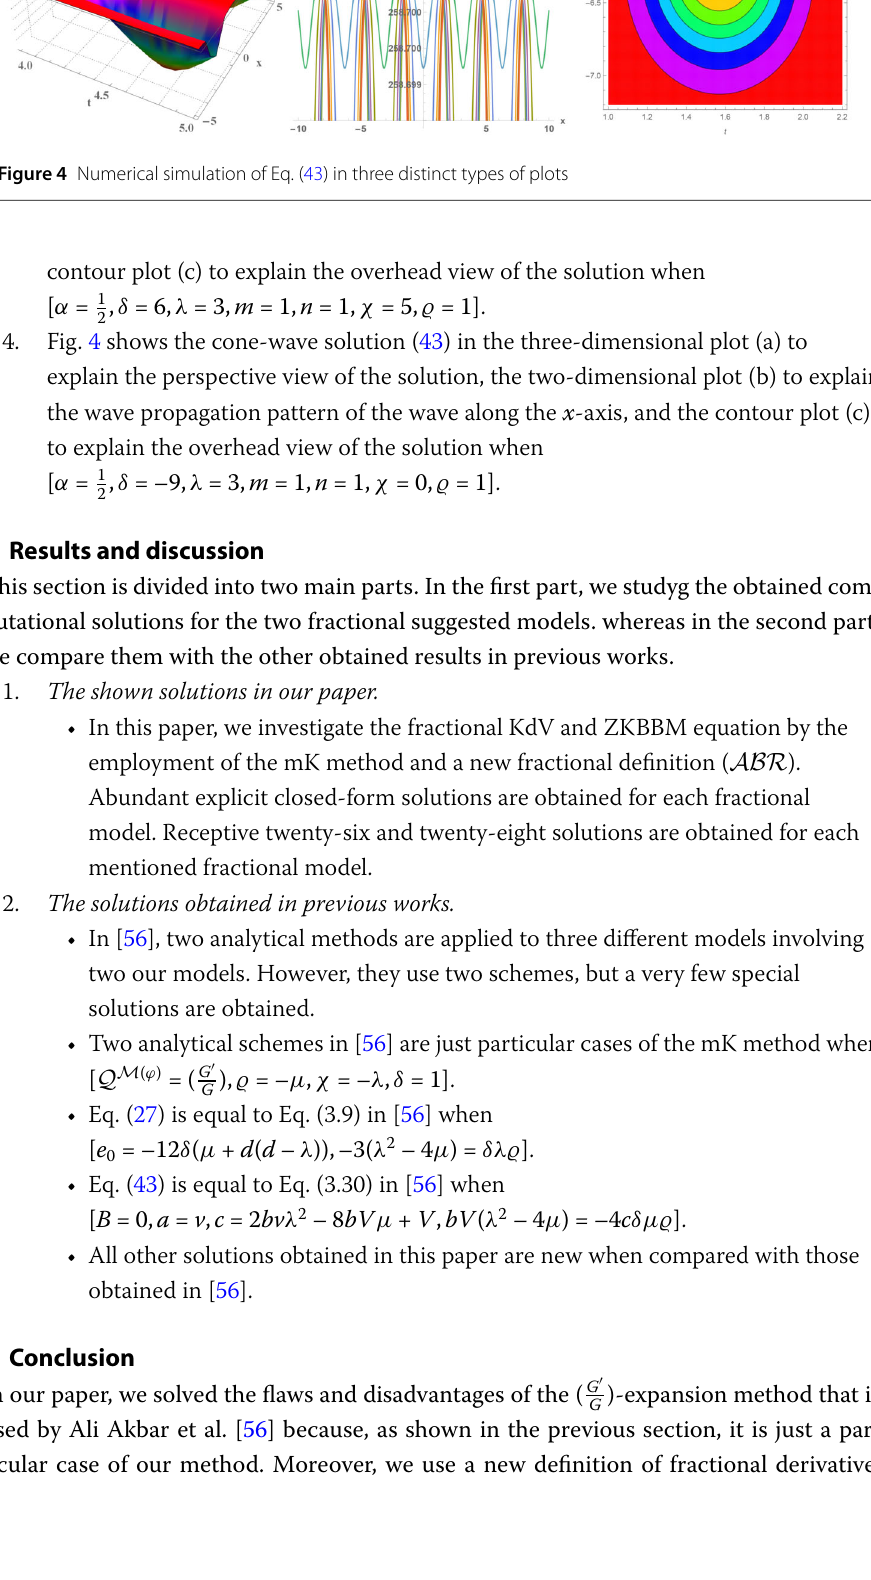
Figure 4 Numerical simulation of Eq. (43) in three distinct types of plots